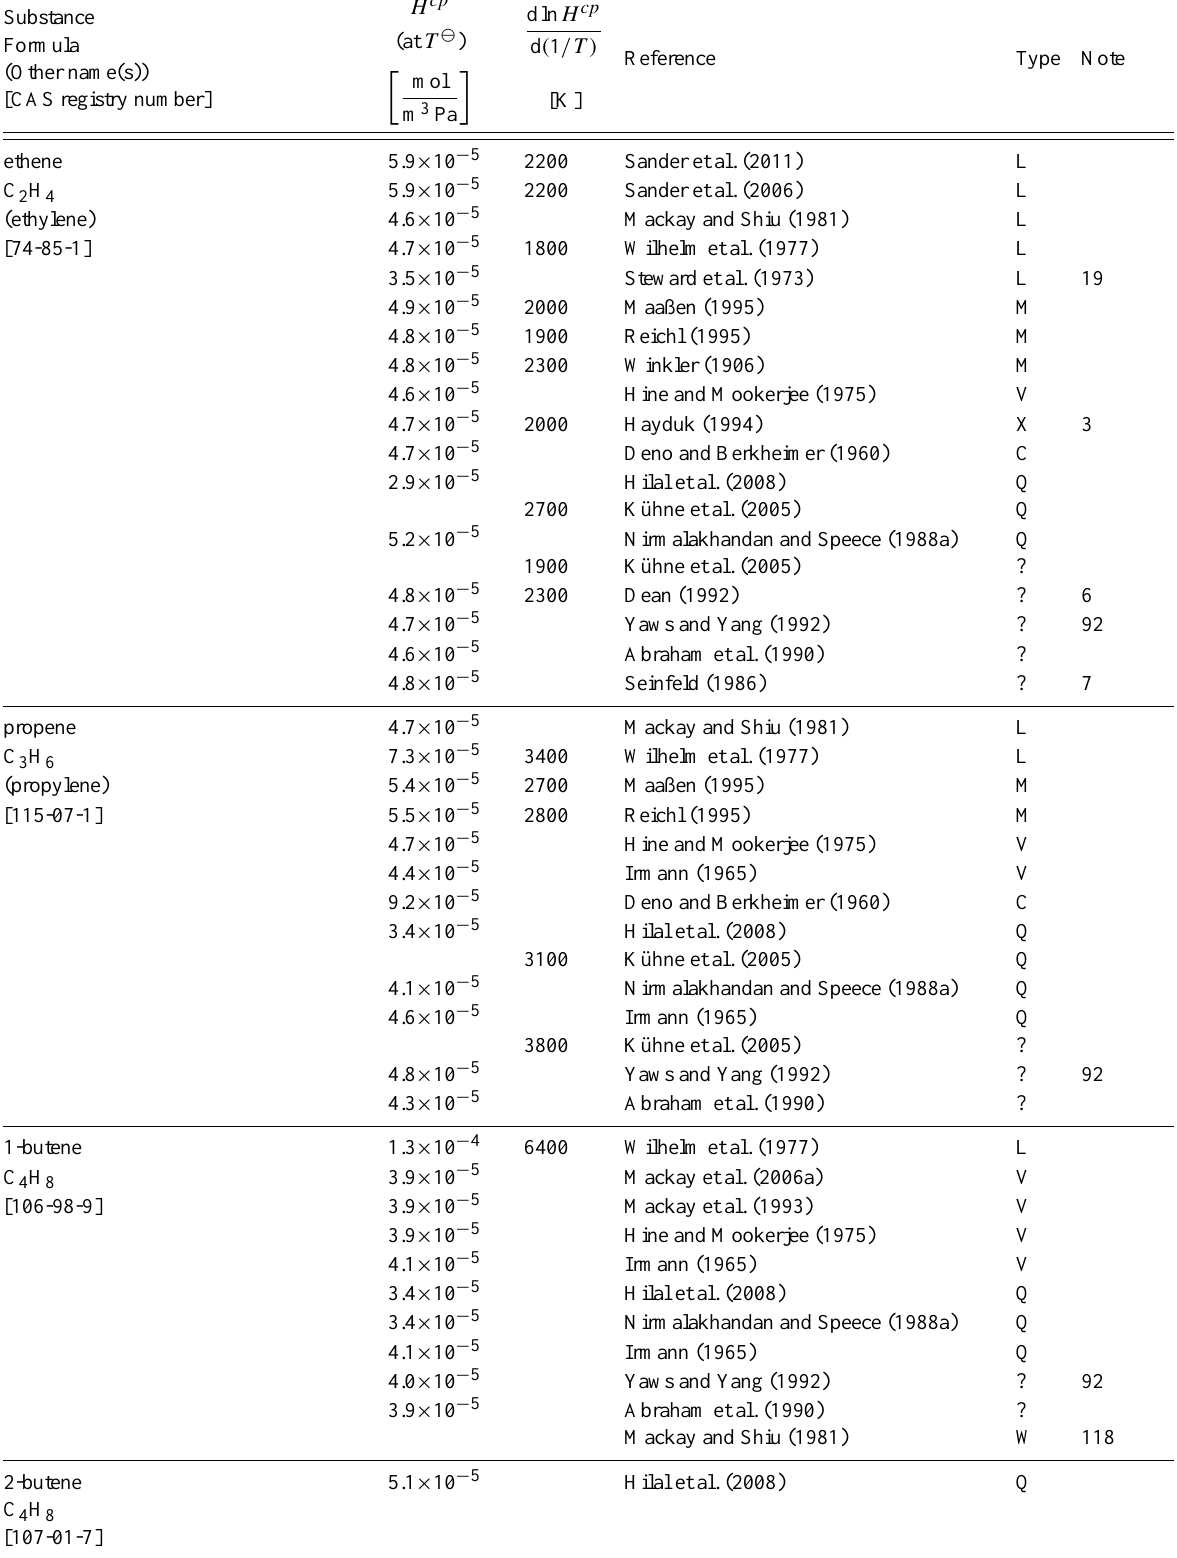
Table 6: Henry’s law constants for water as solvent